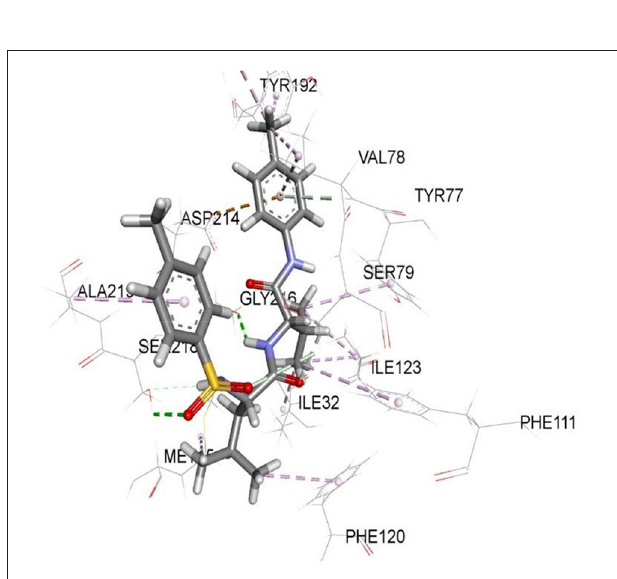
FIGURE 4 | The stereo view of compound 8e in the binding cavity of